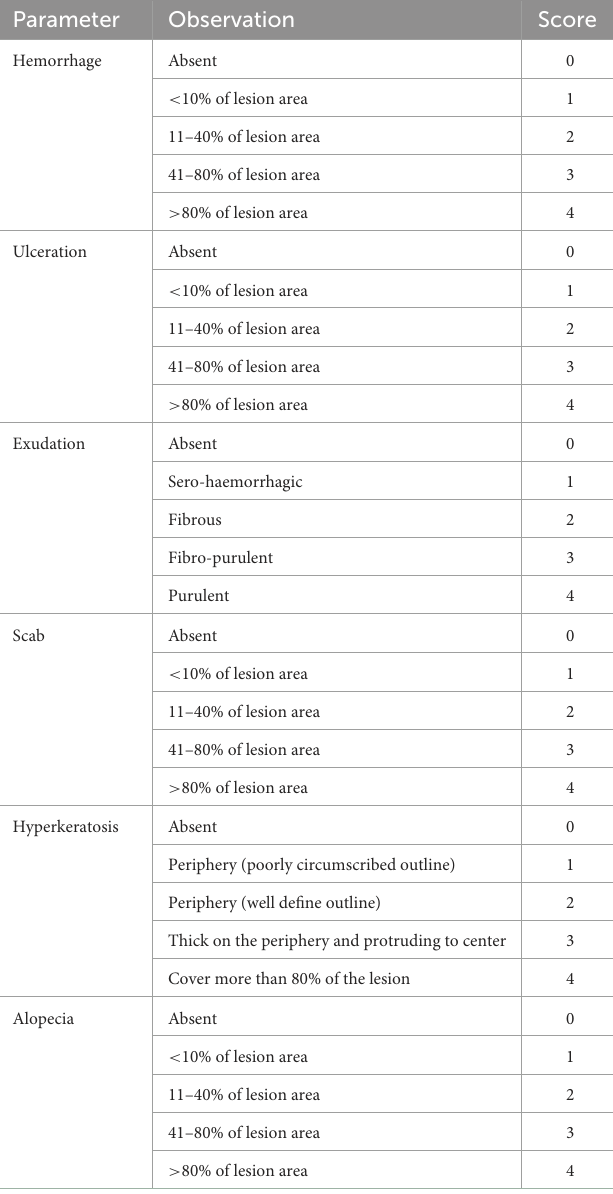
TABLE 1 Grading scales for scoring gross changes in buffalo fly lesions.